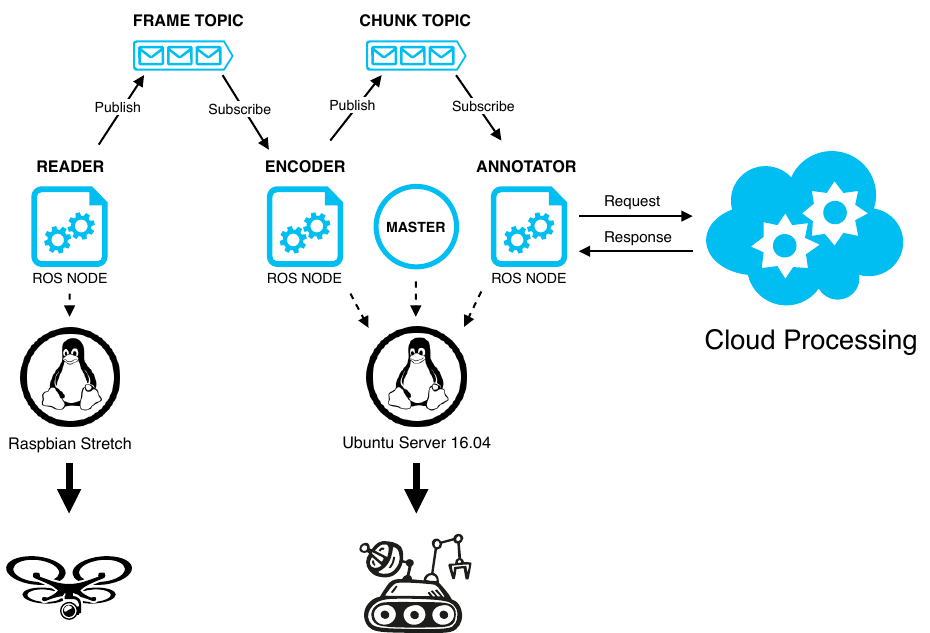
Figure 4. Three-tier architecture of our Dew Robotics Platform based on ROS and for